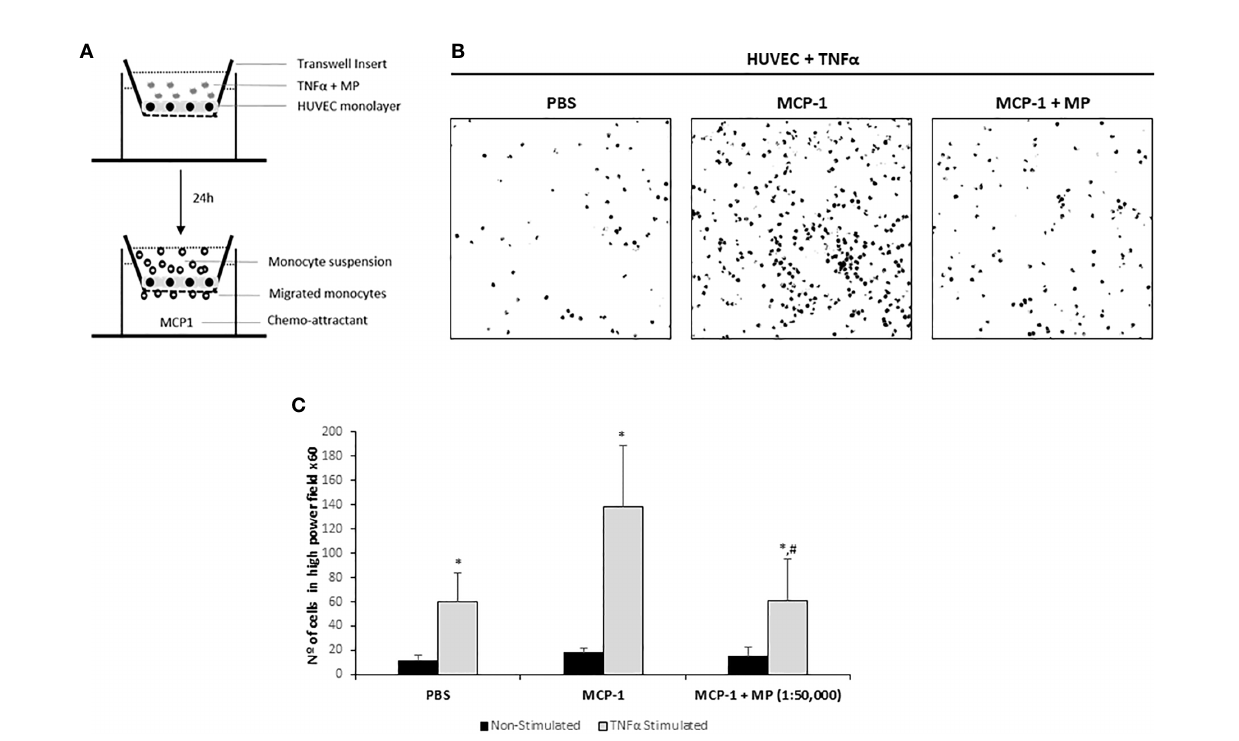
FIGURE 6 | Effect of Membrane Particles on migration of monocytes through a monolayer of TNF a -activated HUVEC. (A) Schematic representation of the transmigration assay. HUVEC were seeded on transwell inserts until con fl uency. The monolayer of cells was treated with TNF a and 1:50,000 MP for 24h. Then, 1x10 5 isolated monocytes were added during 2h with addition of the chemo-attractant MCP-1 in the bottom well. Three pictures from randomly selected areas of the transwell were taken for the quanti fi cation. (B) Representative confocal microscopy images of the negative control (no MCP-1), positive control (MCP-1) and the MP treated group analyzed by ImageJ. (C) Quantitative results of the transmigration assay. Data represent means ± SD of the number of transmigrated monocytes. *p < 0.05 respect to Non-Stimulated HUVEC. # p < 0.05 respect to TNF a stimulated HUVEC non treated with MP in the MCP-1 group.